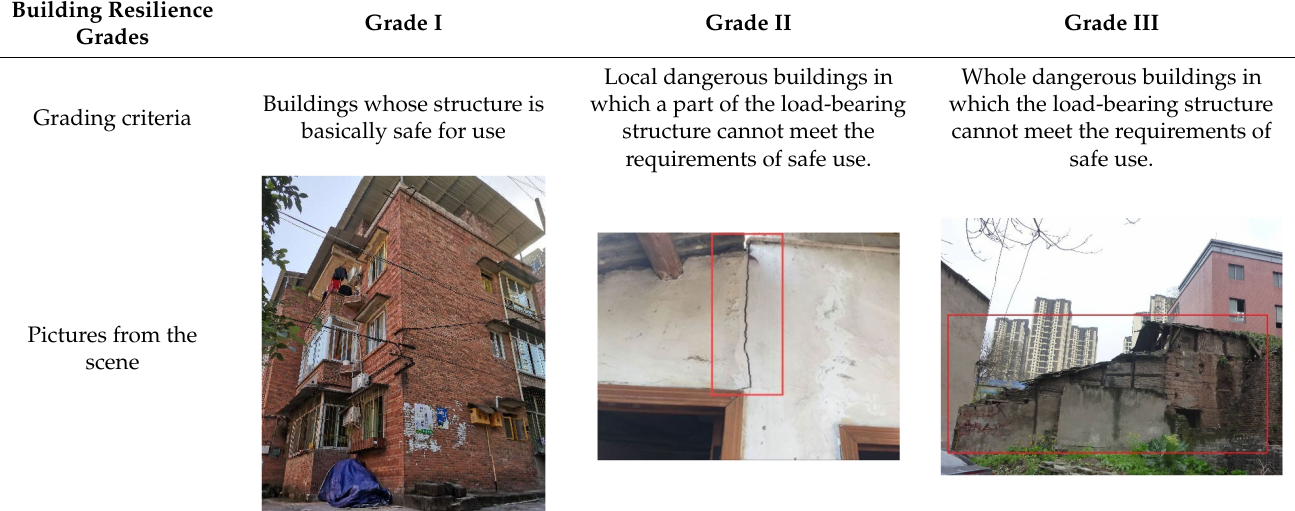
Table 1. Resilience grades of typical buildings.